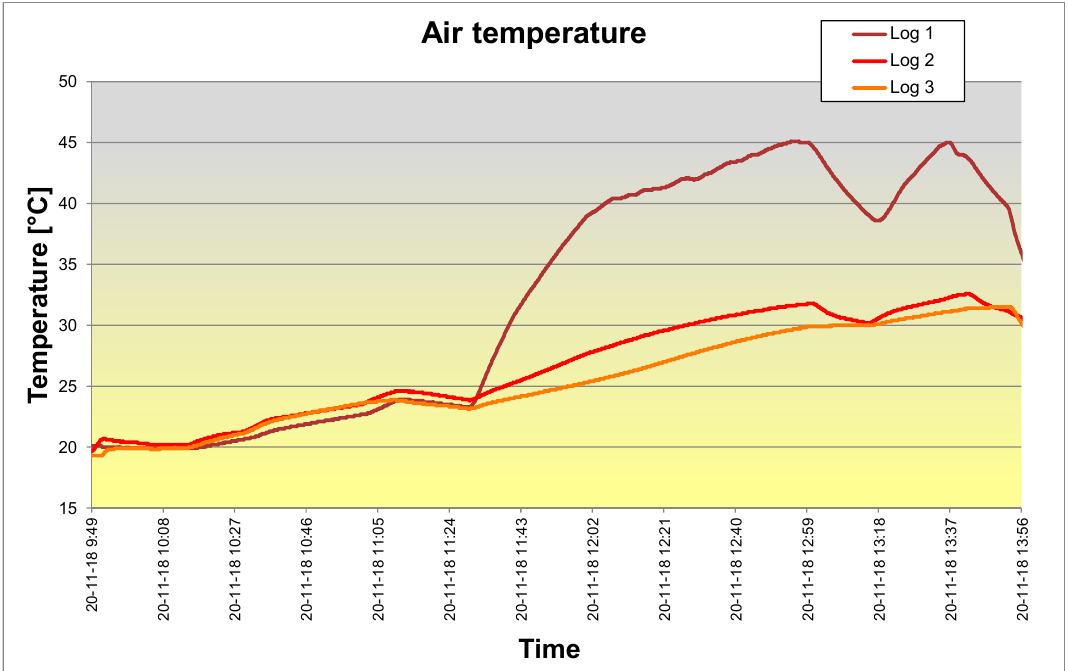
Figure 9. Indoor air temperature of the laboratory recorded by the three loggers.